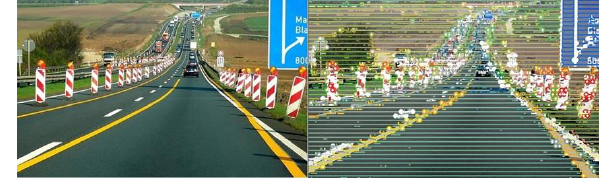
Figure 1 . All color bunches of the right-hand image.